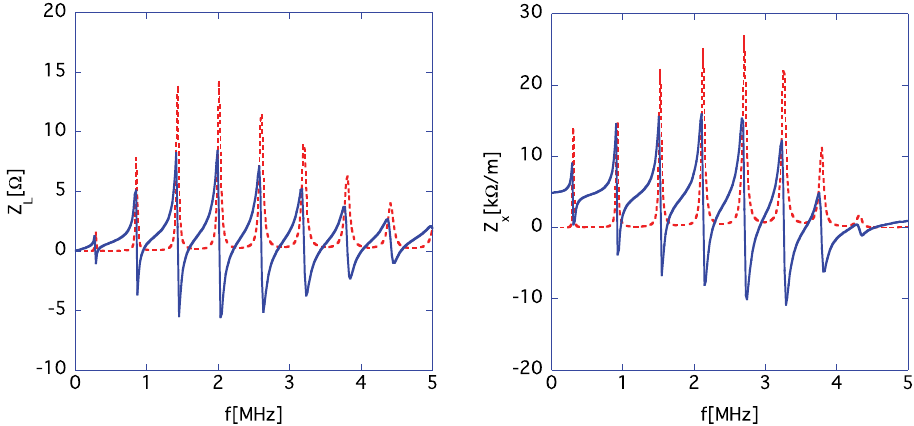
FIG. 3. Theoretical results for the longitudinal (left) and horizontal (right) beam impedances for a relativistic beam, when the cable terminals are open. The red dashed and blue solid lines show the real and imaginary parts of the beam impedances,